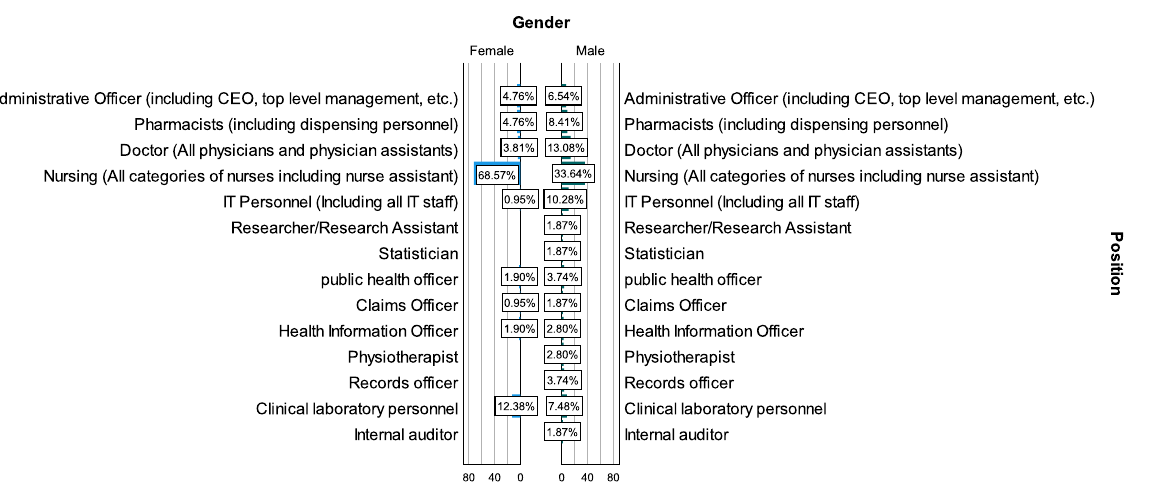
Figure 5. Position distribution by